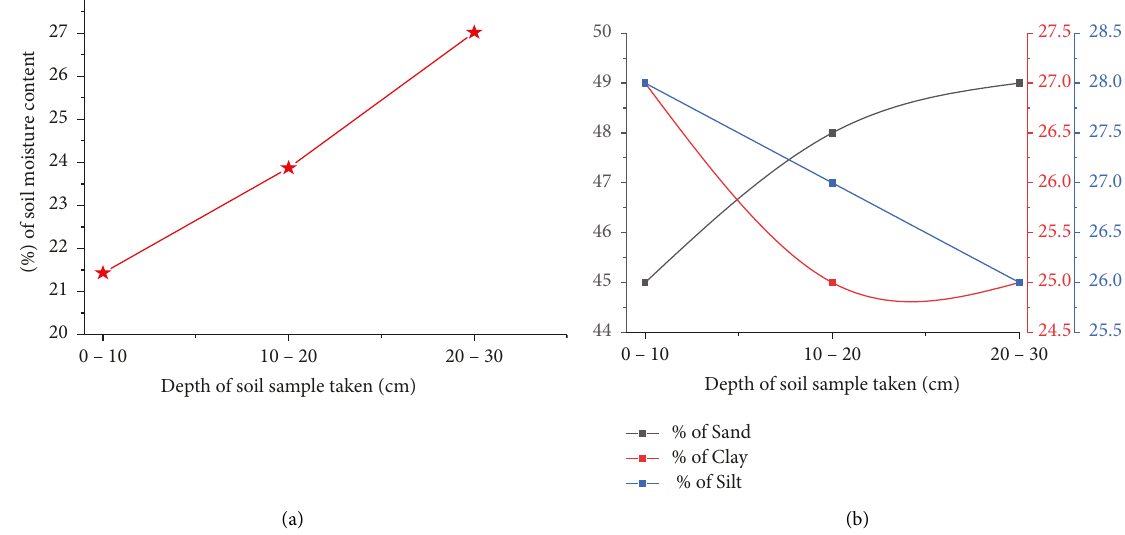
Figure 7: (a) Soil moisture content vs. depth. (b) Soil types percent vs.